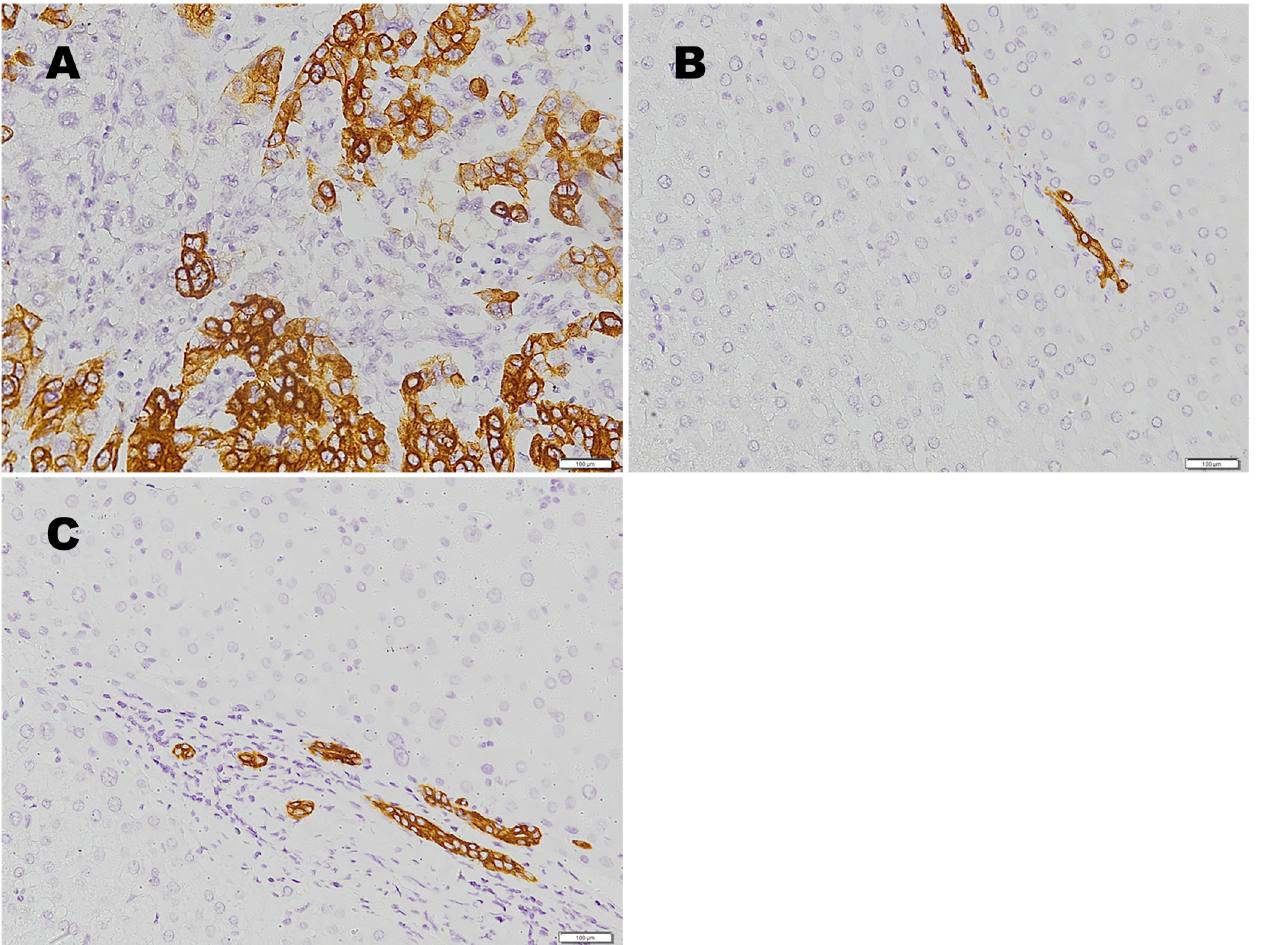
Fig 1. Expression of CK-19 in human primary hepatocellular carcinoma. Immunohistochemical staining of CK-19 in (A) tumor tissues, (B) adjacent non- malignant tissues, and (C) liver cirrhosis tissues. Representative illustrations are shown. Magnification: